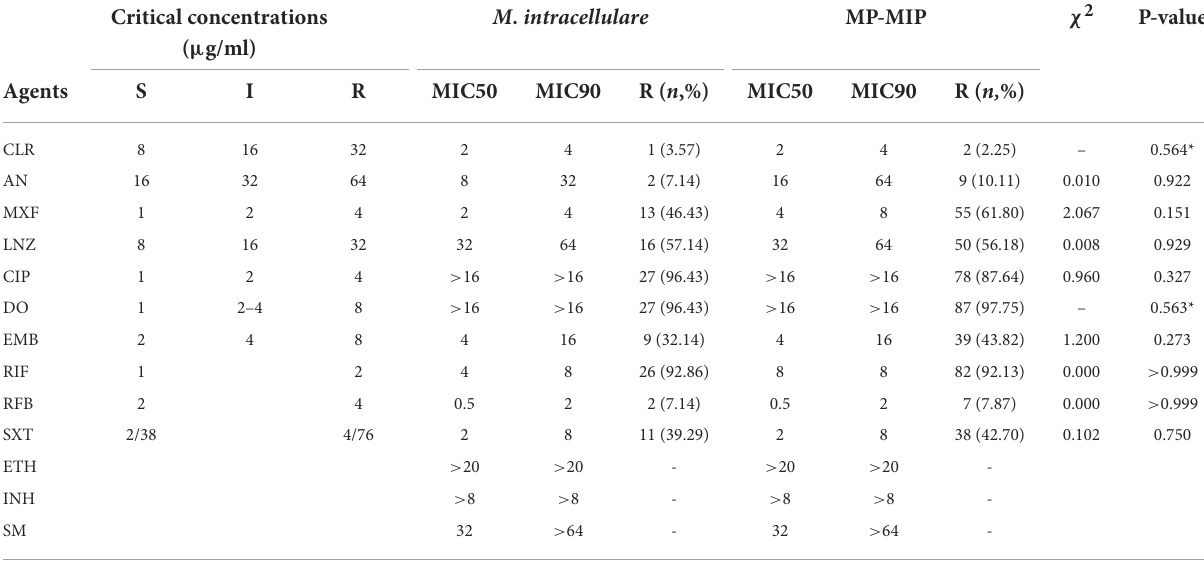
TABLE 1 The antimicrobial susceptibilities and minimum inhibitory concentrations (MICs) of M. intracellulare and MP-MIP strains. Critical